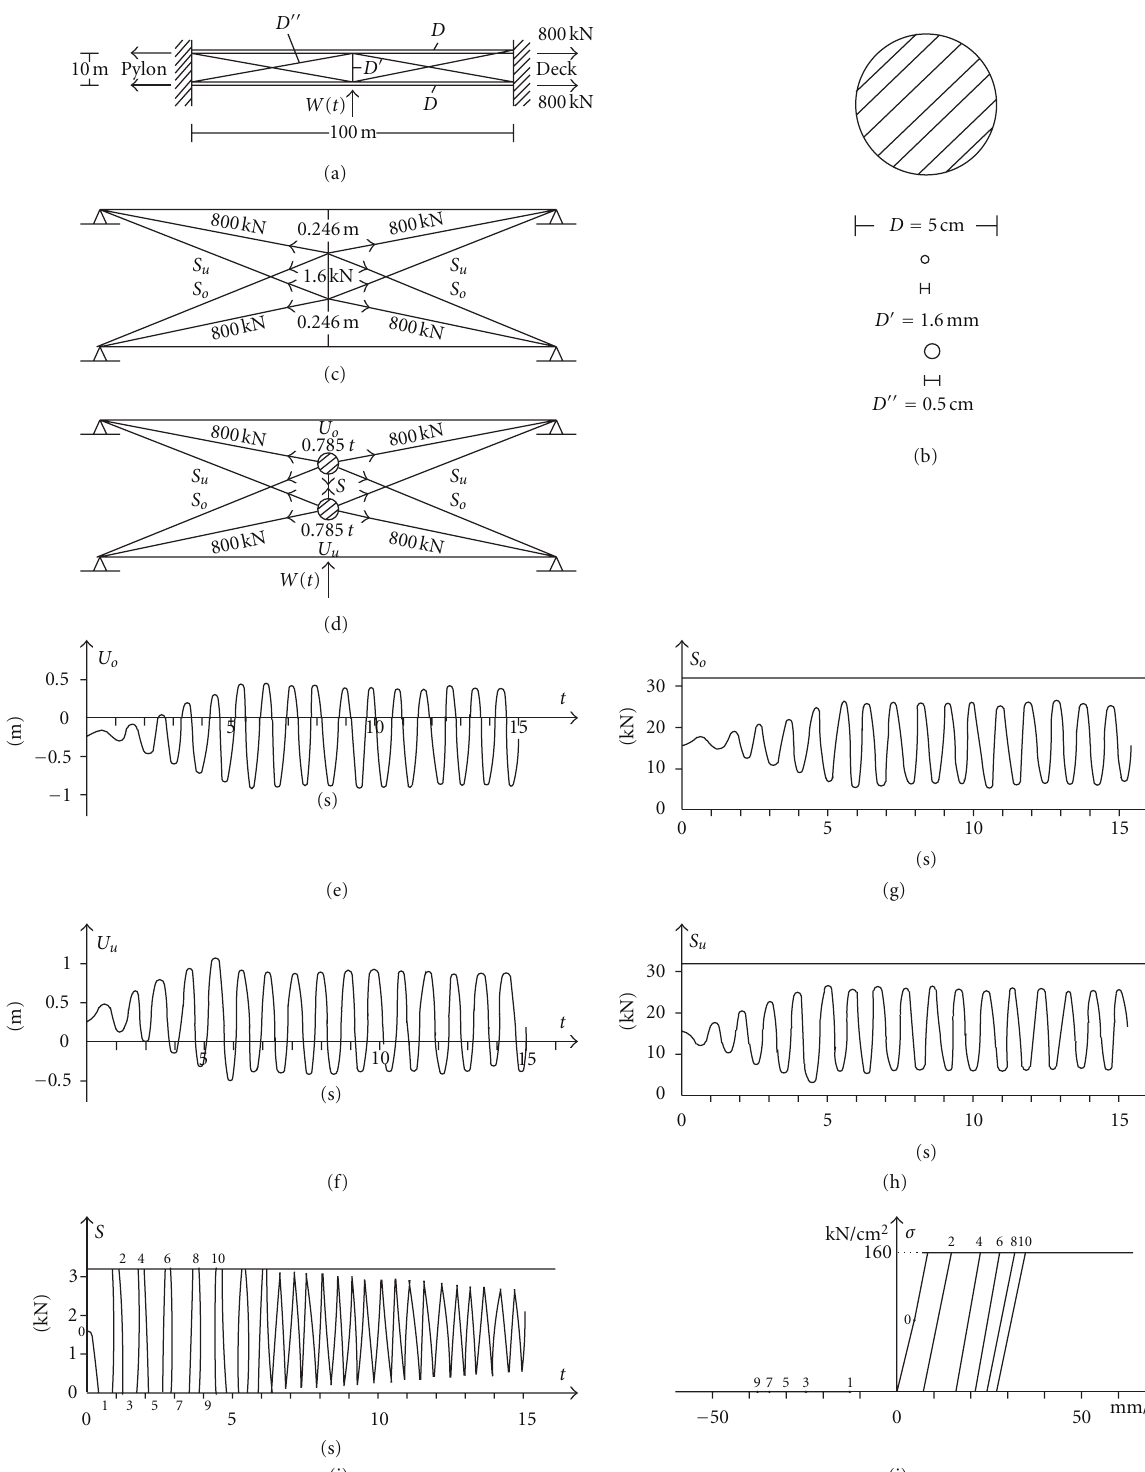
Figure 8: Sixth application: couple of cables interconnected by cross-tie, additionally connected by diagonals to pylon and deck, subject to wind. (a) Given geometry and loading. (b) Cross sections of main cables, cross-tie and diagonals. (c) Initial static analysis. (d) Parameters of dynamic analysis. (e), (f) Resulting time-histories of displacements of two main cables. (g), (h) Resulting time-histories of axial forces of diagonal bars. (i) Resulting time-history of axial force of cross-tie. (j) Resulting stress-strain loops of the